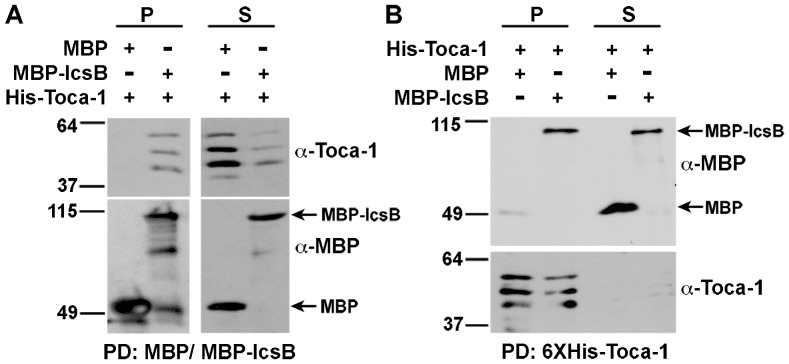
Toca-1 and IcsB reciprocally co-precipitate.Reciprocal co-precipitation of His-Toca-1105–477 and MBP-IcsB from soluble fractions of E. coli BL21 DE3 that co-express the two proteins or the relevant controls, using amylose (for MBP, panel A) or cobalt (for His, panel B) resin. Western blot analysis. The apparent degradation observed for the Toca-1 construct was independent of IcsB. Apparent molecular weights in kilodaltons are indicated to the left of the blots. P, pellet; S, supernatant.